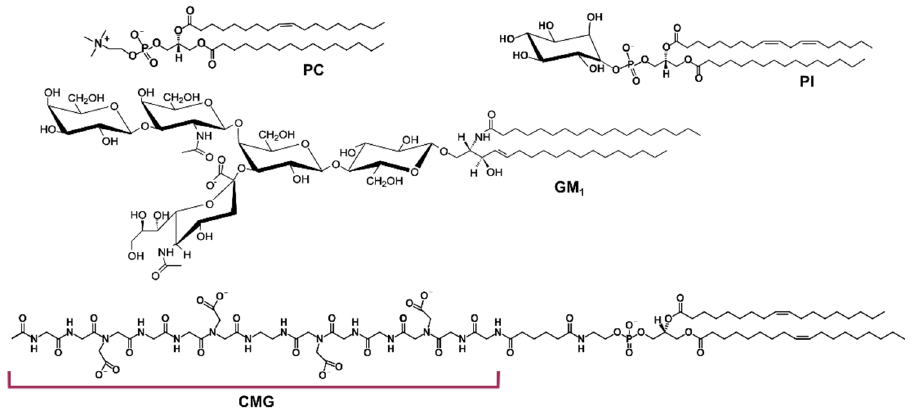
Figure 1. Chemical structures of the components of liposomes used in this study. Representative